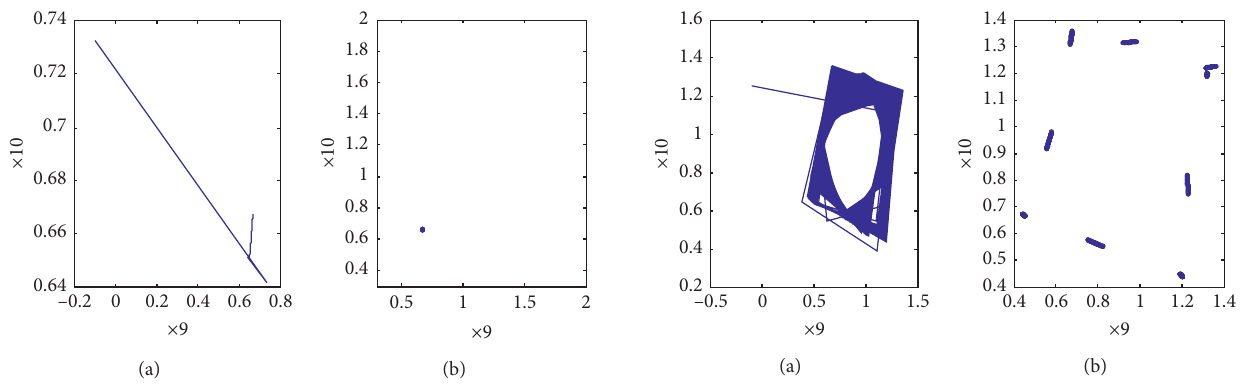
Figure 25: ω � 192 and k � 0with the Coulomb model when w t ∈ 0 . 05 0 . 0581 􏼂 􏼃 . (a) Phase trajectories. (b) Poincare maps.